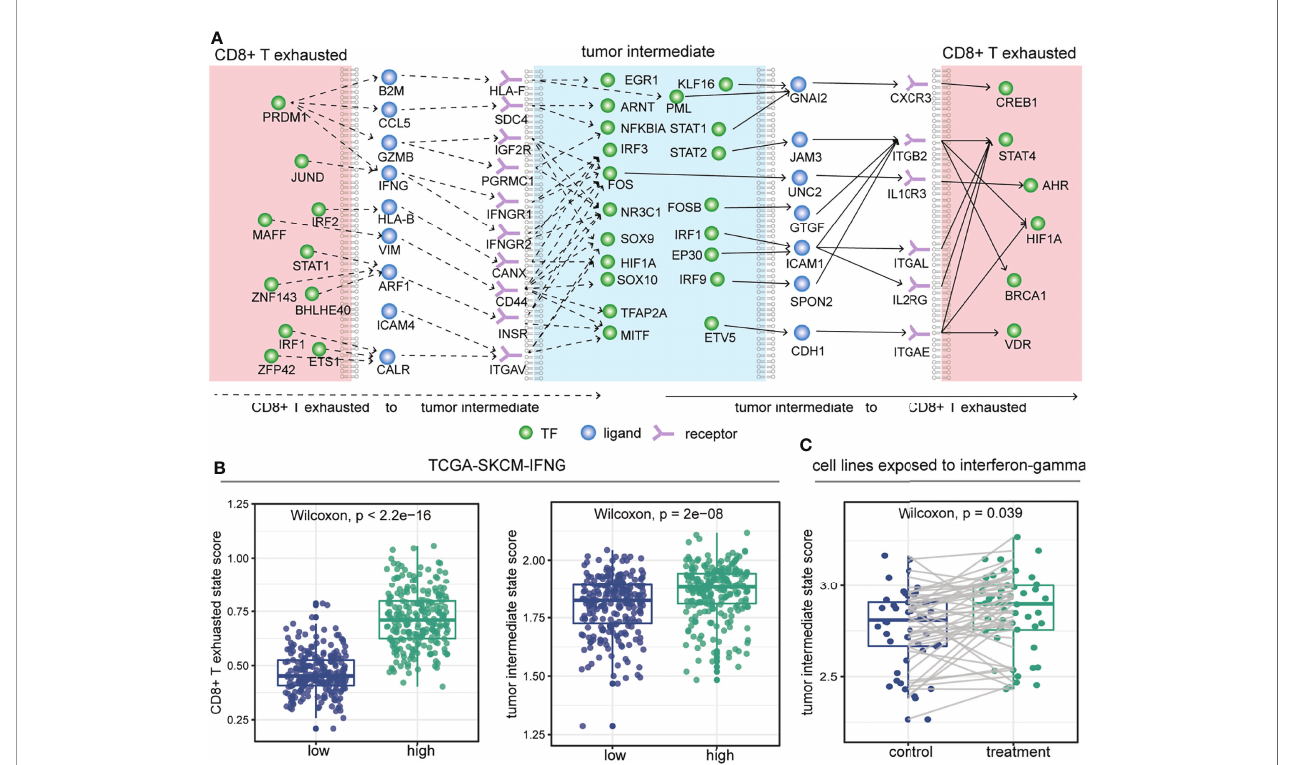
FIGURE 6 | Inter/intracellular signal transduction network between the tumor intermediate state and the CD8+ T exhausted state. (A) Selected inter/intracellular signal transduction network (TF – ligand – receptor – TF) between the tumor intermediate state and the CD8+ T exhausted state. (B) Comparison of CD8+ T exhausted state ssGSEA score (left) and tumor intermediate state ssGSEA score (right) between high- and low-expressed groups de fi ned by the median expression level of IFNG in the TCGA-SKCM cohort. (C) In 48 melanoma cell lines (GSE154996), comparison of tumor intermediate state ssGSEA score between before (control) and after 6 hours (treatment) of treatment with